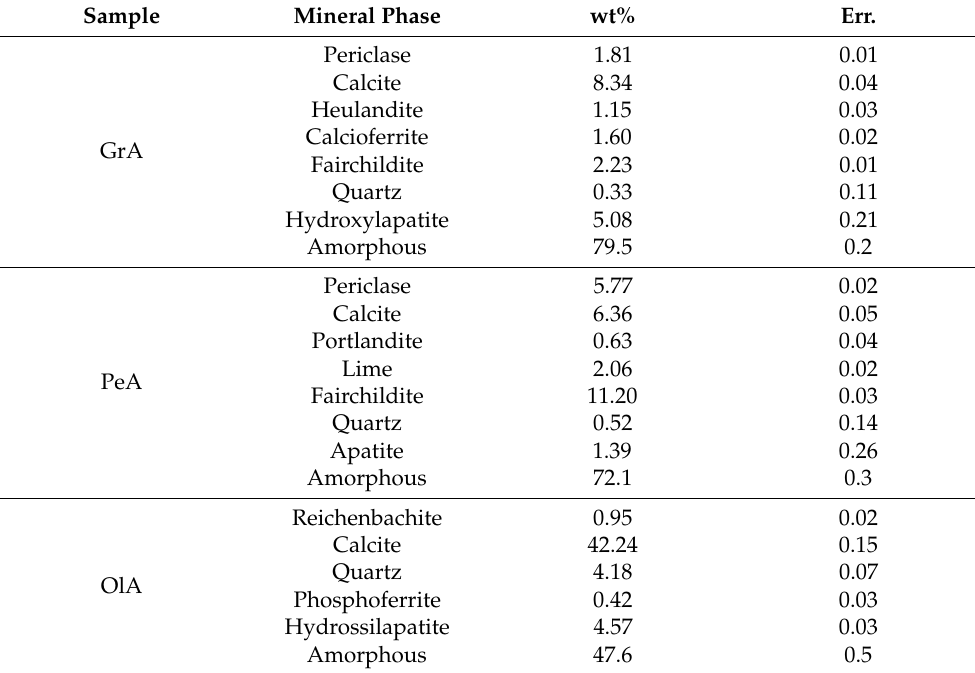
Mineralogical composition of selected biomass ashes. Data were taken from Comodi et al. [24]. Data are given as the weight percent (wt%), together with their relative errors (err) in the wt%